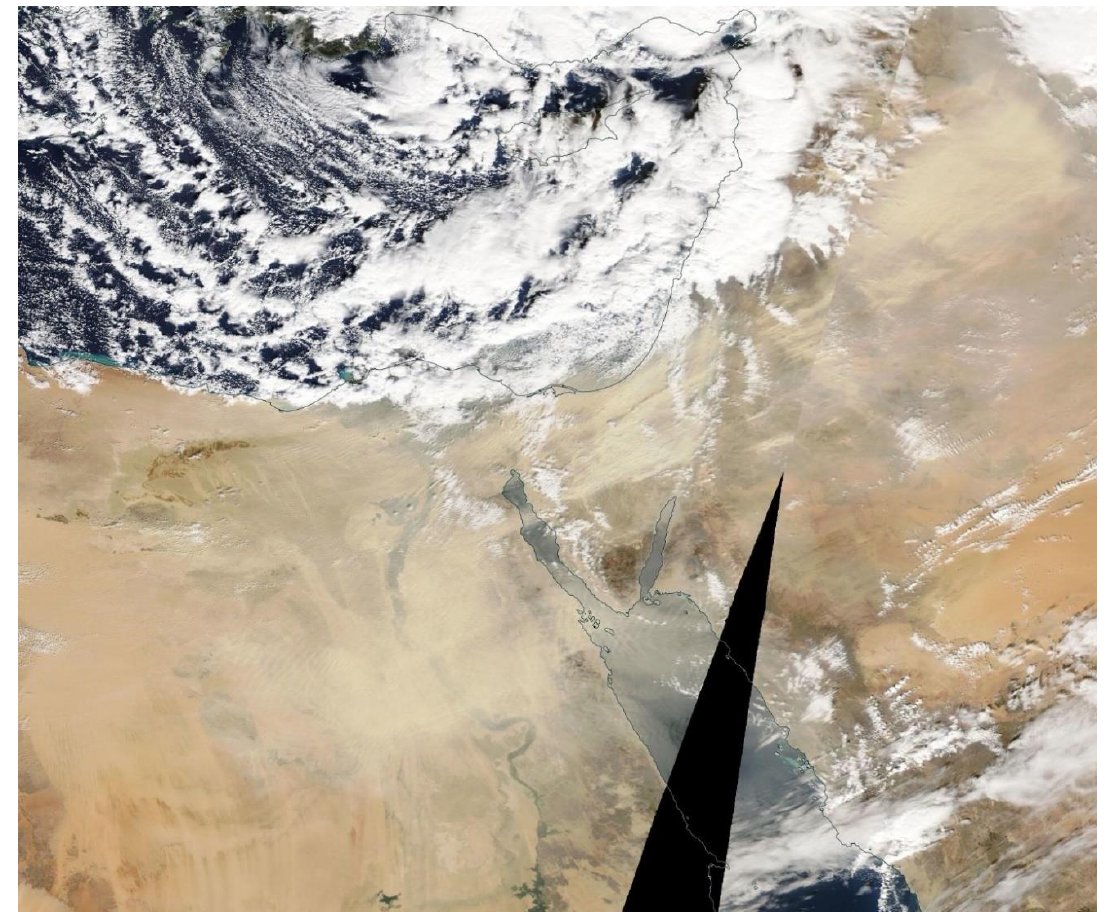
Figure 6. Regional satellite image from the Terra Moderate Resolution Imaging Spectroradiometer (MODIS) taken at approximately 1030 local on 12 December 2010.